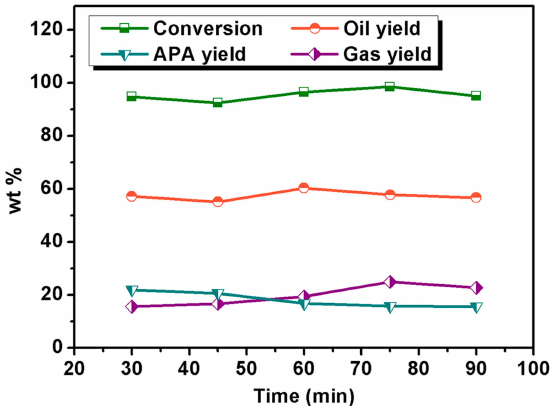
Figure 5. Results of the catalytic hydrogenation of Dahuangshan coal with Fe 3 O 4 nanoparticles in different holding times.